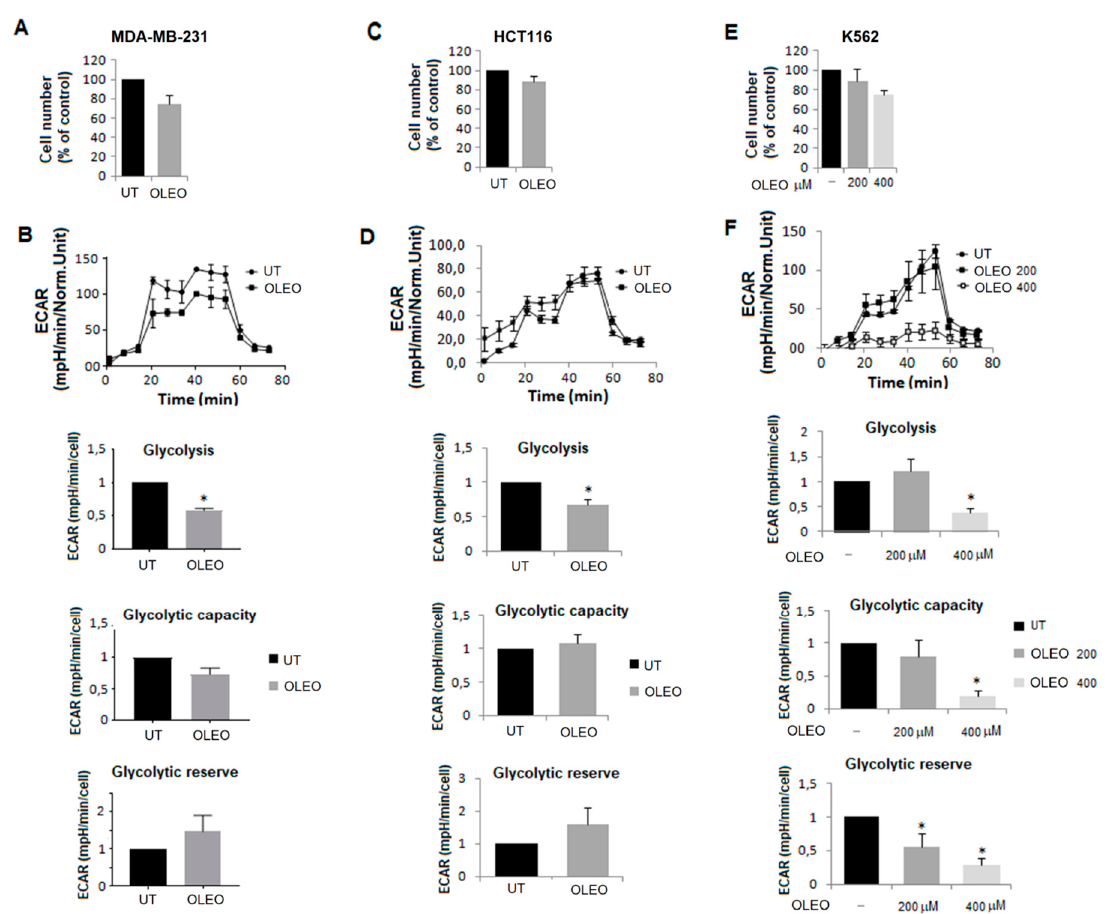
Figure 4. Effect of OLEO on glycolytic metabolism of breast cancer, colon carcinoma and myeloid leukemia cells. Cell number ( A , C , E ) and representative results of a glucose stress test of MDA-MB-231 ( B ), HCT116 ( D ), and K562 ( F ) cells, treated with 200 or 400 µ M OLEO for 48 h. Plots on the right represent glycolysis, glycolytic reserve and glycolytic capacity extracted from glycolysis stress assay results obtained using the Seahorse Analyzer. Significance is indicated with *.